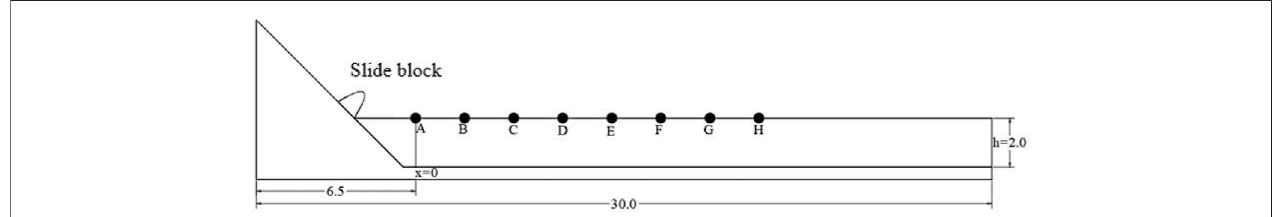
FIGURE 3 | Parabolic numerical model diagram (m).